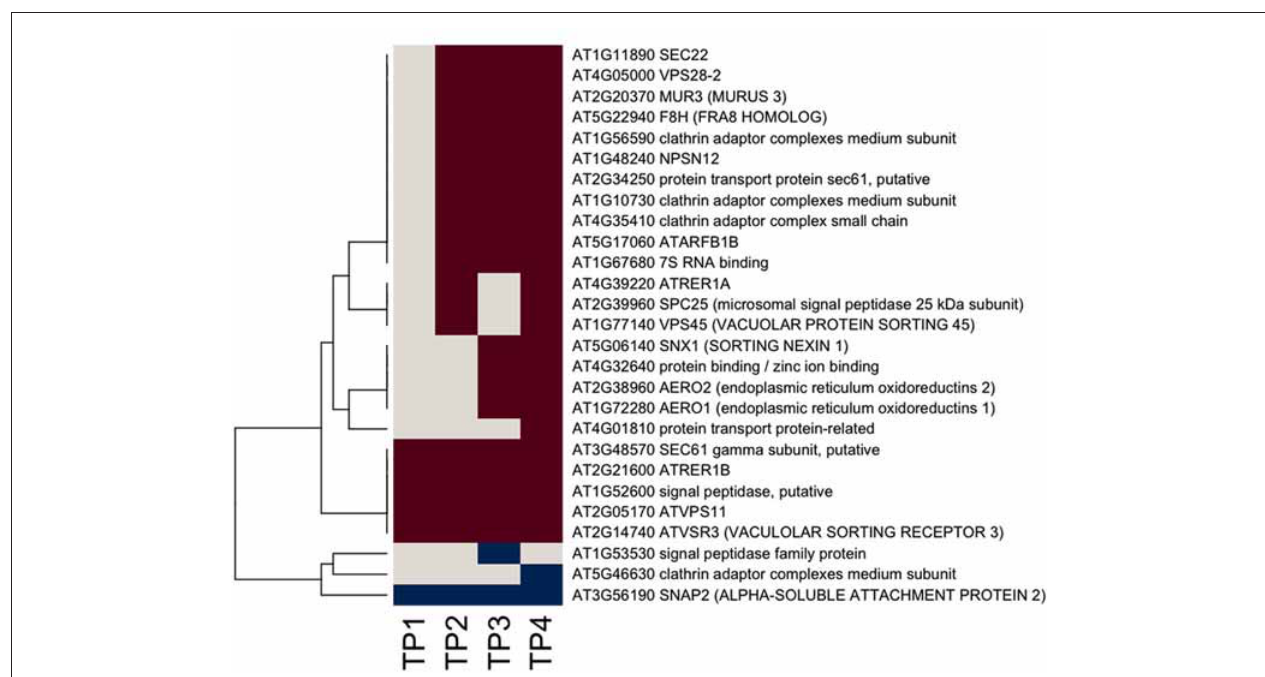
FIGURE 3 | Heat map of significantly responsive endomembrane/ secretory pathway associated genes across the time course of winter hardening. The gene expression levels across the rows are hierarchically